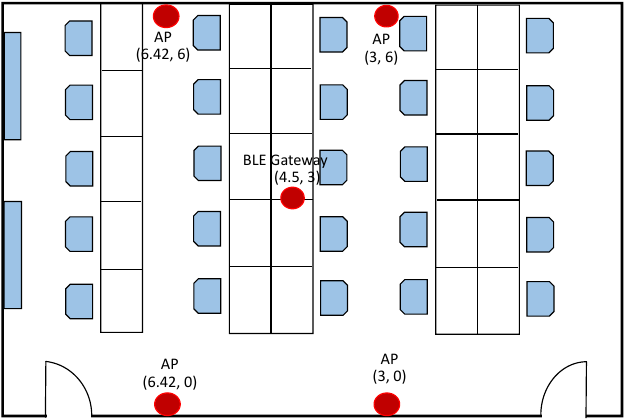
Figure 6. Experimental environment.